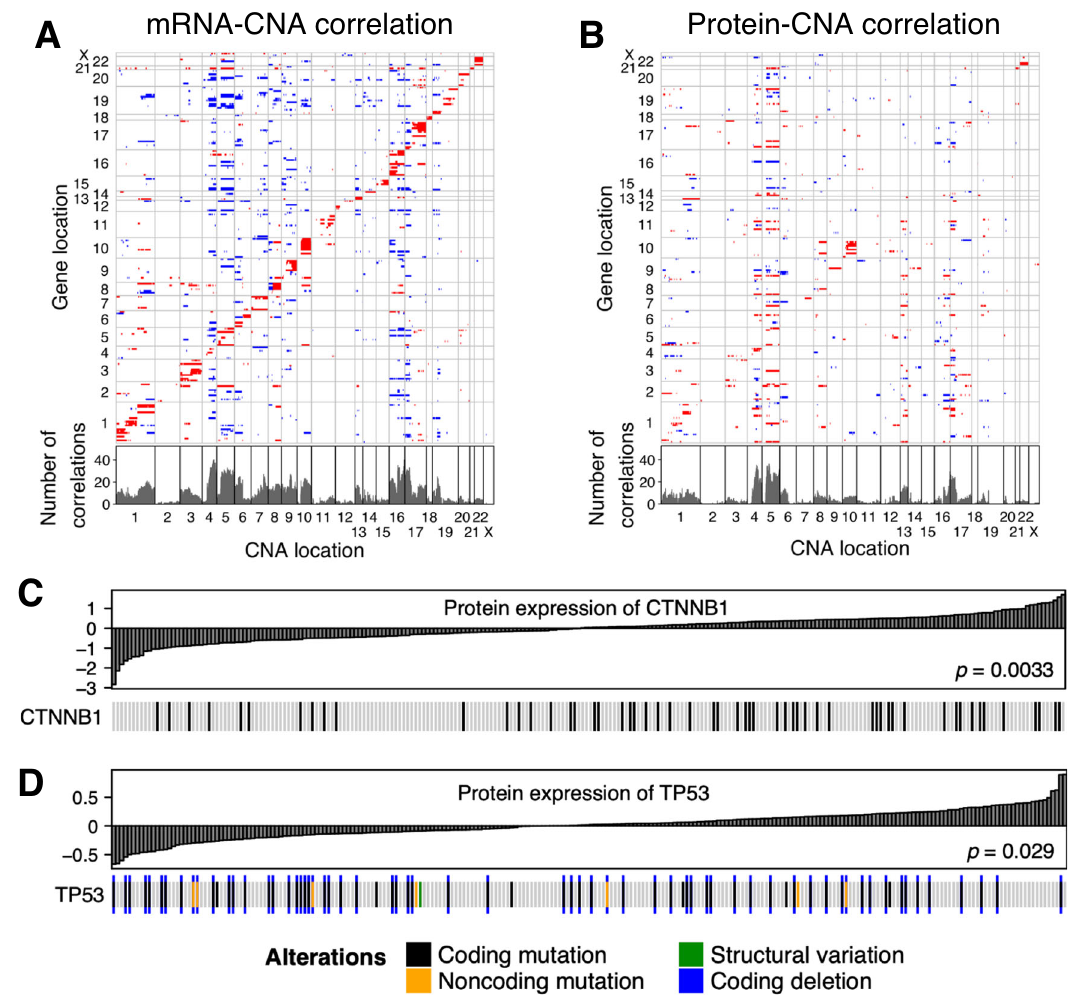
Fig. 2 | Correlationbetweenproteinexpressionlevels and somaticalterations. A , B Local and distant effects of somatic copy number alterations on gene expression levels intumor.Correlation of CNA with A mRNA expression levels and B protein expression levels. The horizontal axis is the genomic coordinates of CNAs. The vertical axis represents the genomic coordinates of 209 genes, which were identical between mRNA and protein analysis. Spearman ’ s correlation between copy number signals and expression levels were computed. Signi fi cant